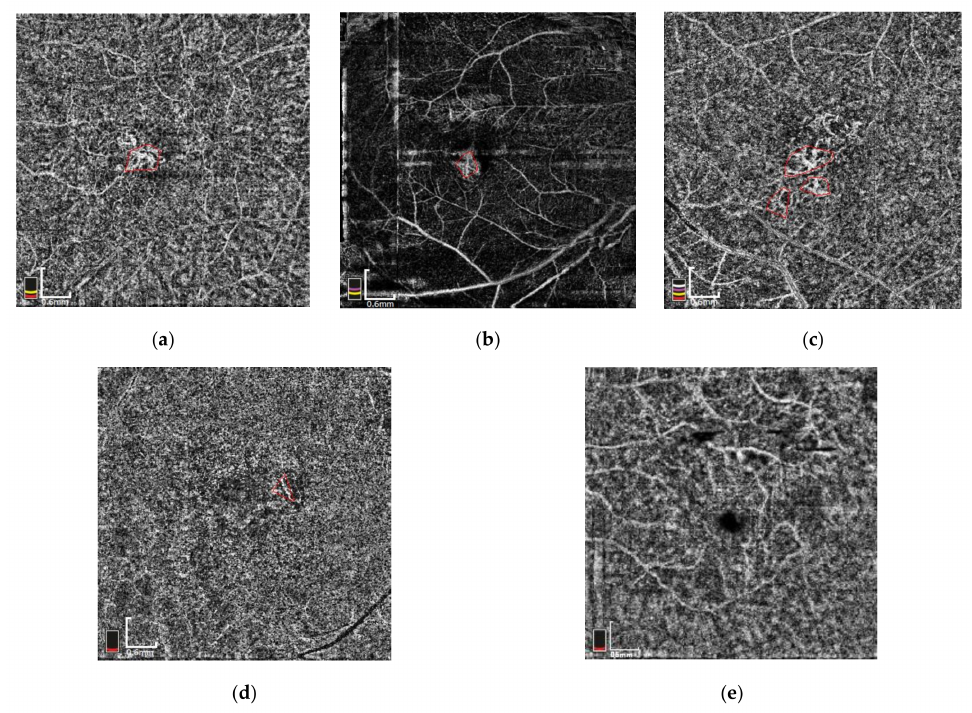
Figure 9. Some final detection results. CNV was found in Figure ( a )–( d ) but not found in Figure ( e